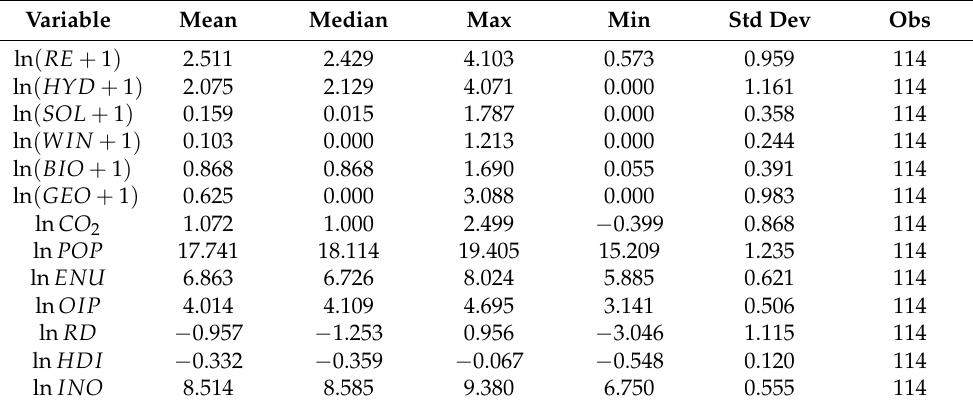
Table 3. Variables summary statistics from 2000 to 2018.